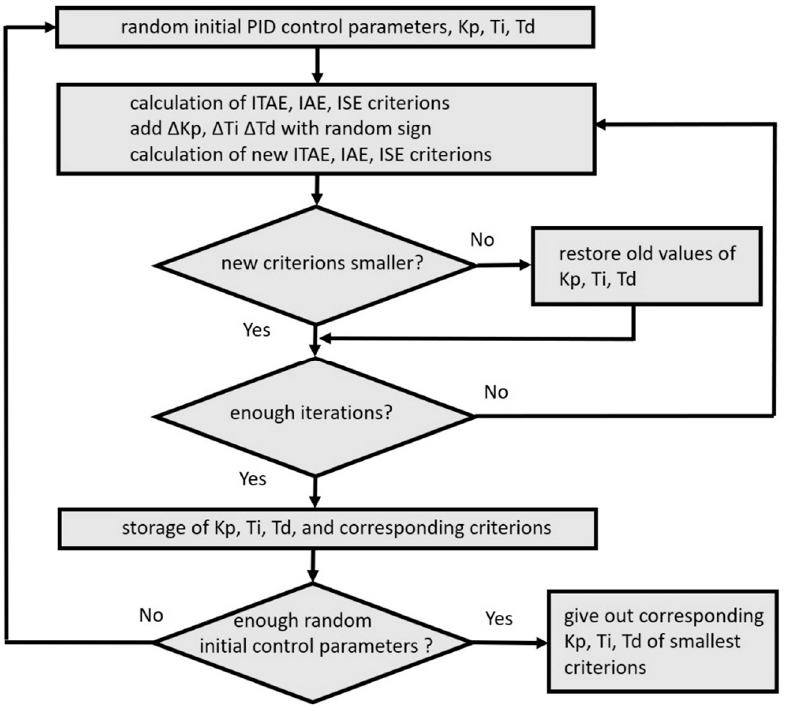
Figure 5. Flow chart of the hill-climbing method for finding the parameters Kp, Ti and Td.